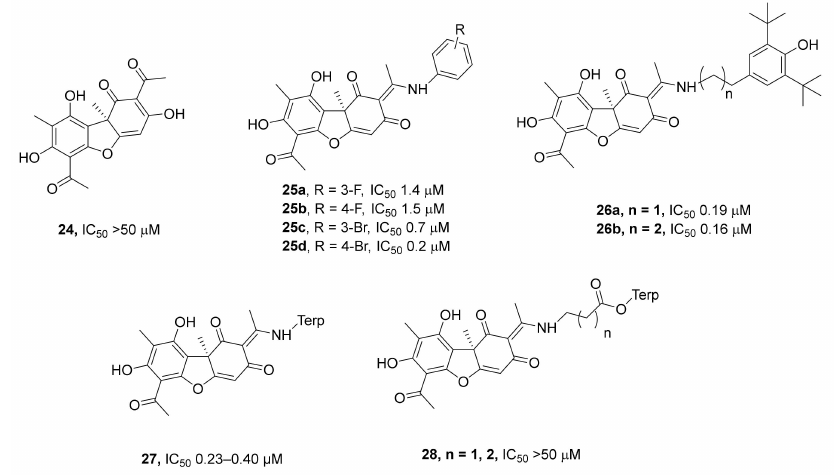
Figure 8. Enamine derivatives of usnic acid as inhibitors of